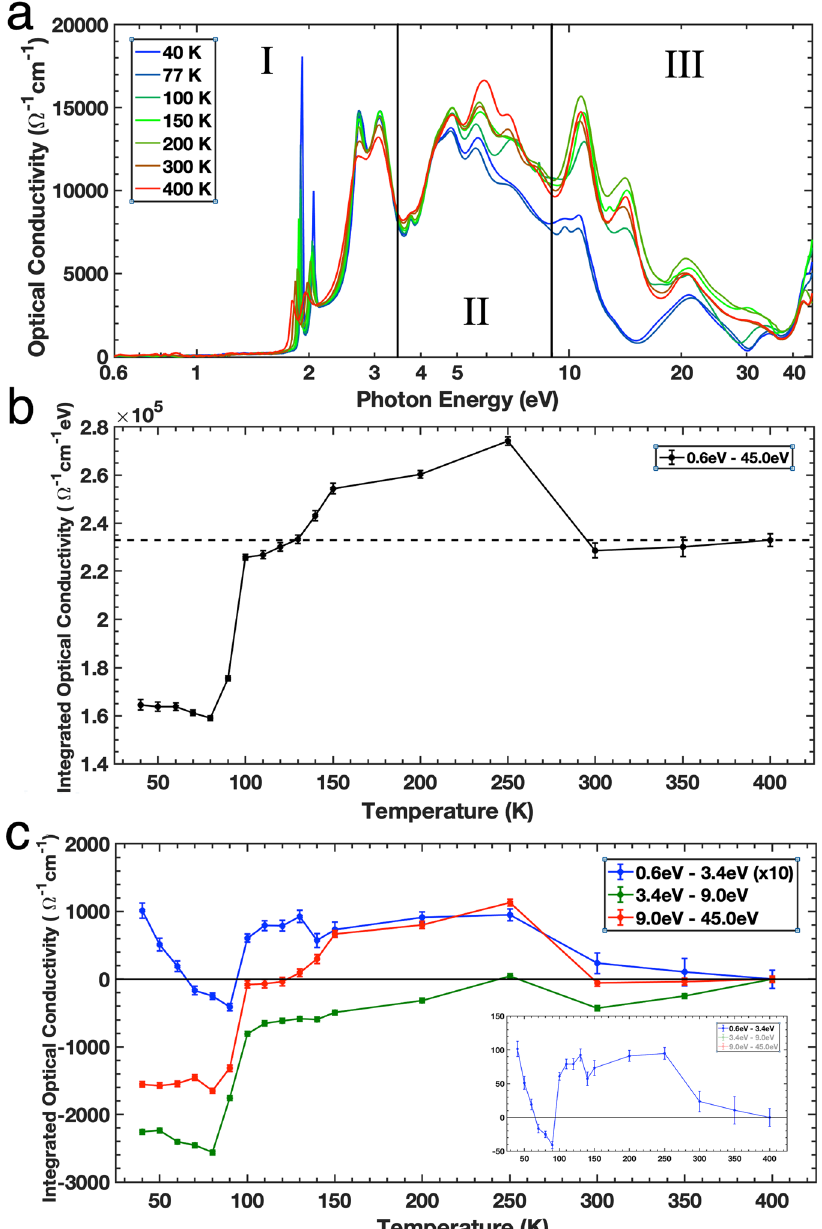
Fig. 3 Spectral weight transfer of MoS 2 . a The optical conductivity of MoS 2 of selected temperatures divided into three spectral regions. b The optical conductivity integrated over the whole spectrum as a function of temperature. Error bars are calculated using a 20 meV shift of spectral divide. c The relative change in integrated optical conductivity of the three different spectral regions as the sample is cooled from 400 to 40 K. Region I has been magni fi ed for clarity. Inset: Original values of Region I. Error bars are calculated using a 20 meV shift of spectral